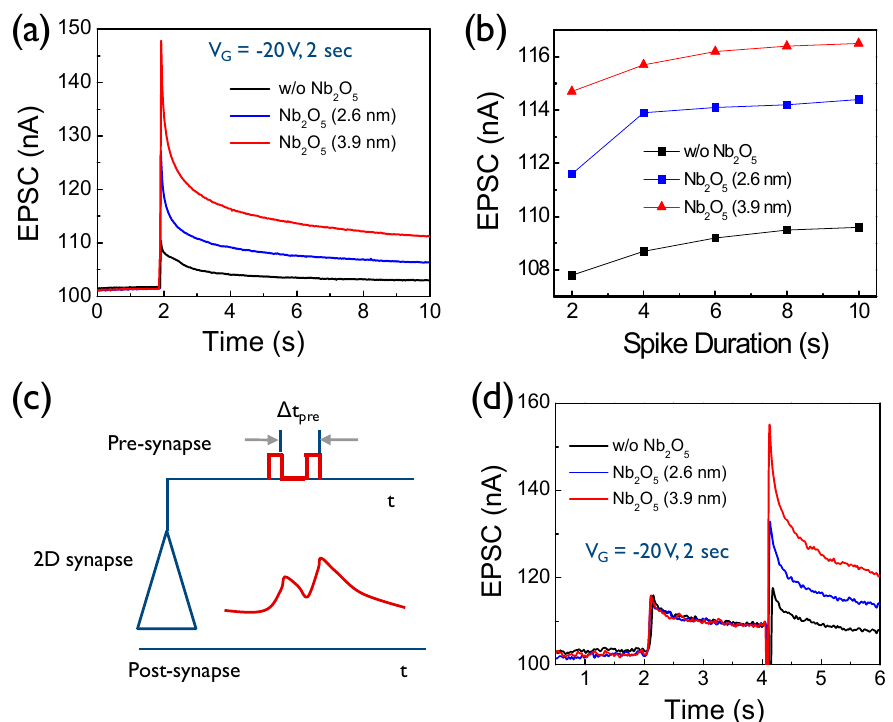
Figure 5. ( a ) Comparison of the excitatory post-synaptic current (EPSC) behavior of the 2D heterostructure devices with different Nb 2 O 5 interlayer thicknesses. ( b ) Comparison of the EPSC data as a function of the spike duration time for the different 2D heterostructure devices. ( c ) Operation scheme of the synapse circuit for describing paired pulse facilitation that is stimulated by the application of two sequential pulses. ( d ) Comparison of paired pulse facilitation behavior for the different 2D heterostructure devices.